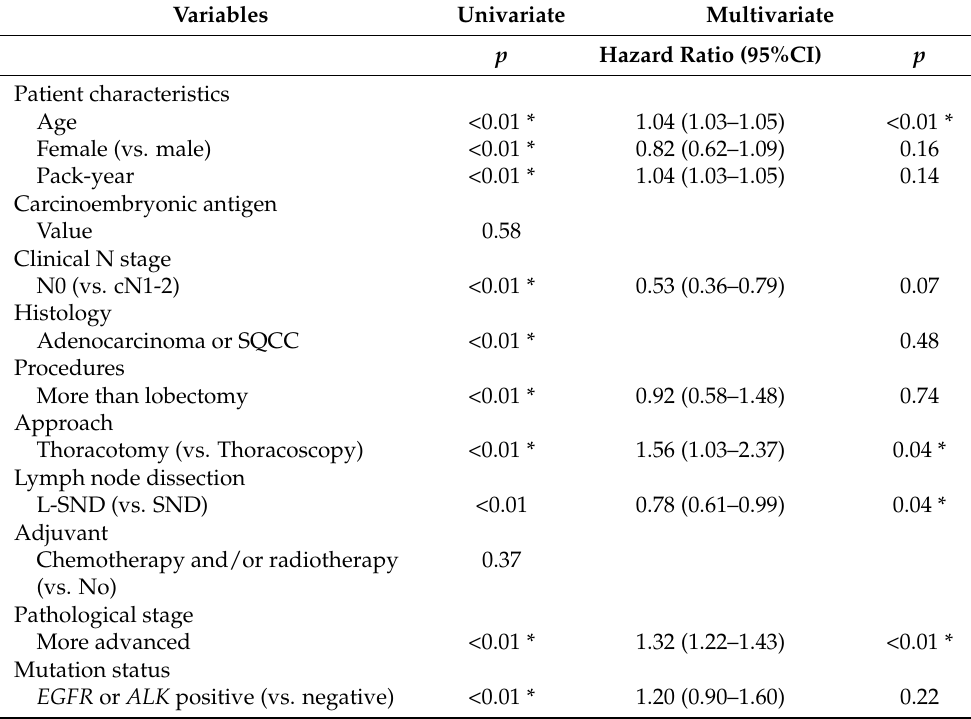
Table 4. Univariate and multivariate analyses for overall